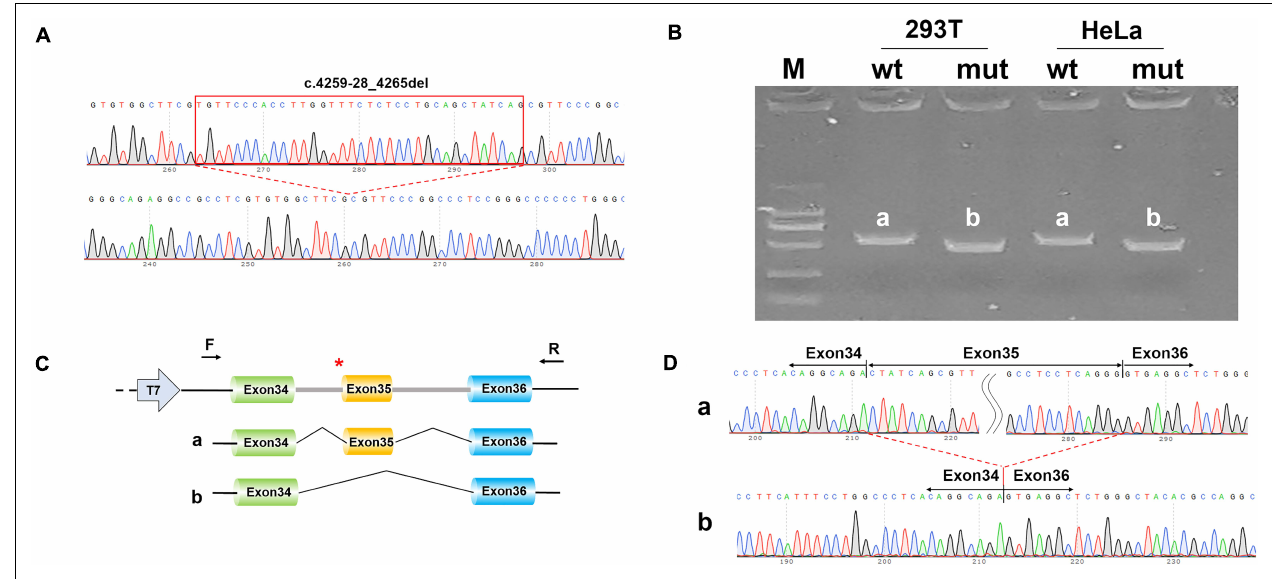
FIGURE 3 | Alternative splicing assays in minigene. (A) Sequencing results of pcDNA3.1-wt (wild type) fragment (top) and pcDNA3.1-mut (mutant fragment) with c.4259-28_4265del of COL18A1 (bottom). (B) Gel view of reverse transcription polymerase chain reaction (RT-PCR). The size of expression of pcDNA3.1-COL18A1-wt (band a) is larger than that of pcDNA3.1-COL18A1-mut in both 293T cell and HeLa cell. (C) Schematic diagram of minigene construction and schematic diagram of expression. The “a” represents the normal mRNA composed of exon 34, exon 35, and exon 36, while the “b” represents the aberrant mRNA with exon 36 skipped. * indicates the mutation position. (D) Sequencing results of the bands in (B)